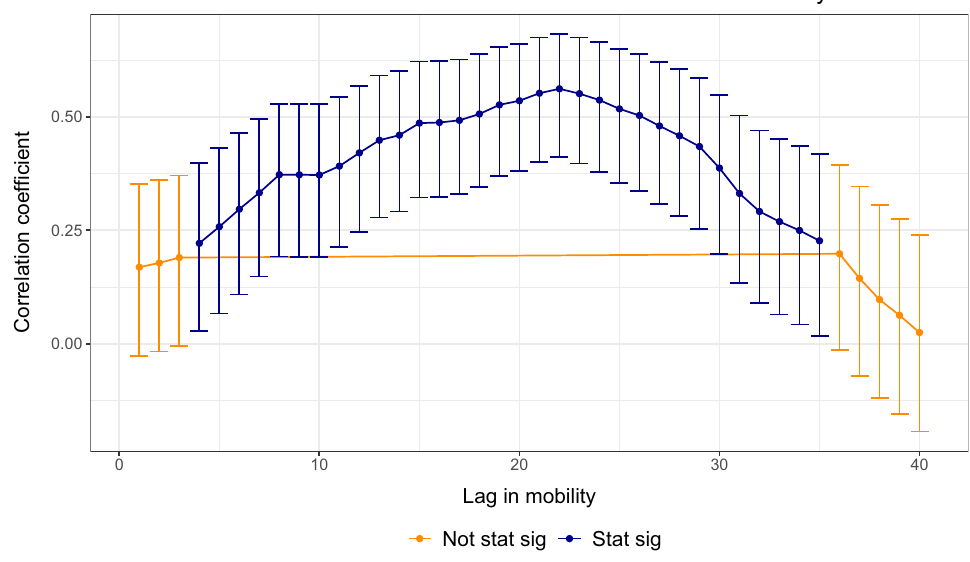
Figure 10. Normalised correlations: relationship between the growth rate ratio and mobility-normalised. The optimal lag occurs around 21 days. This may account for lags in the time people notice symptoms of COVID19 after some days and lags in the reporting of cases for each regional healthcare systems.